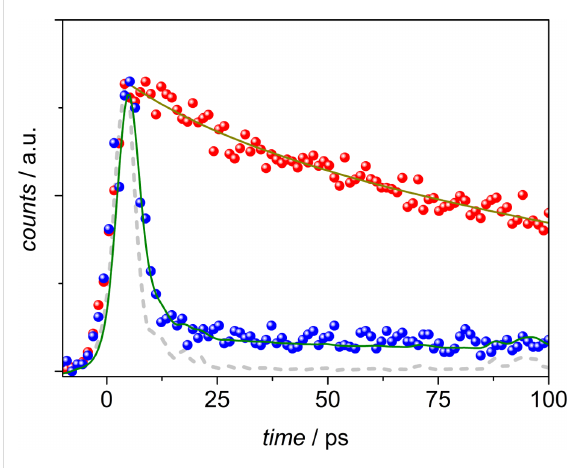
Figure 3: Fluorescence decays (dots) in the 500–520 nm spectral region (red; induced Z -emission), and in the 440–460 nm spectral region (blue) for 1 in toluene upon excitation of the E -form at 350 nm. The fittings are reported as full lines. The excitation profile is shown in dashed light